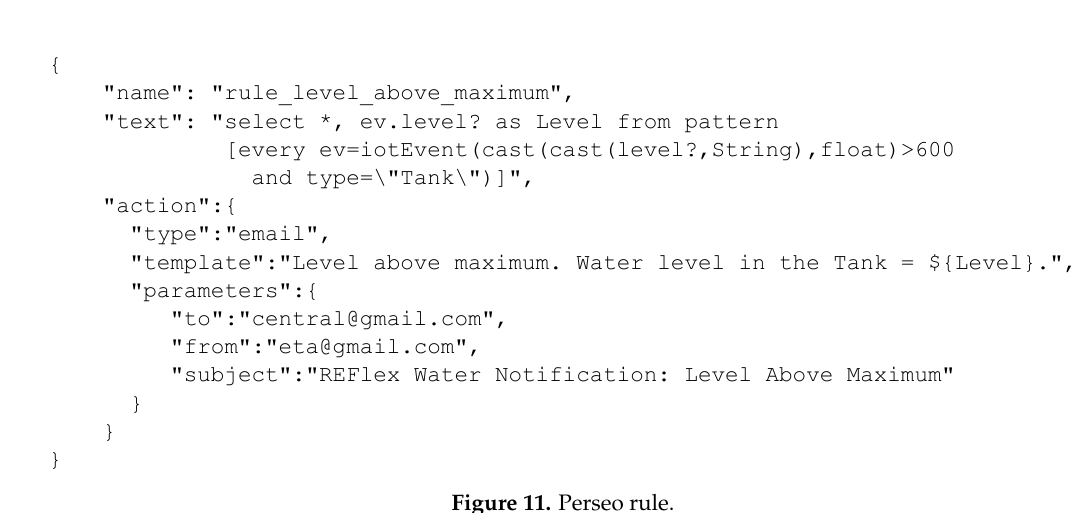
Figure 11. Perseo rule.